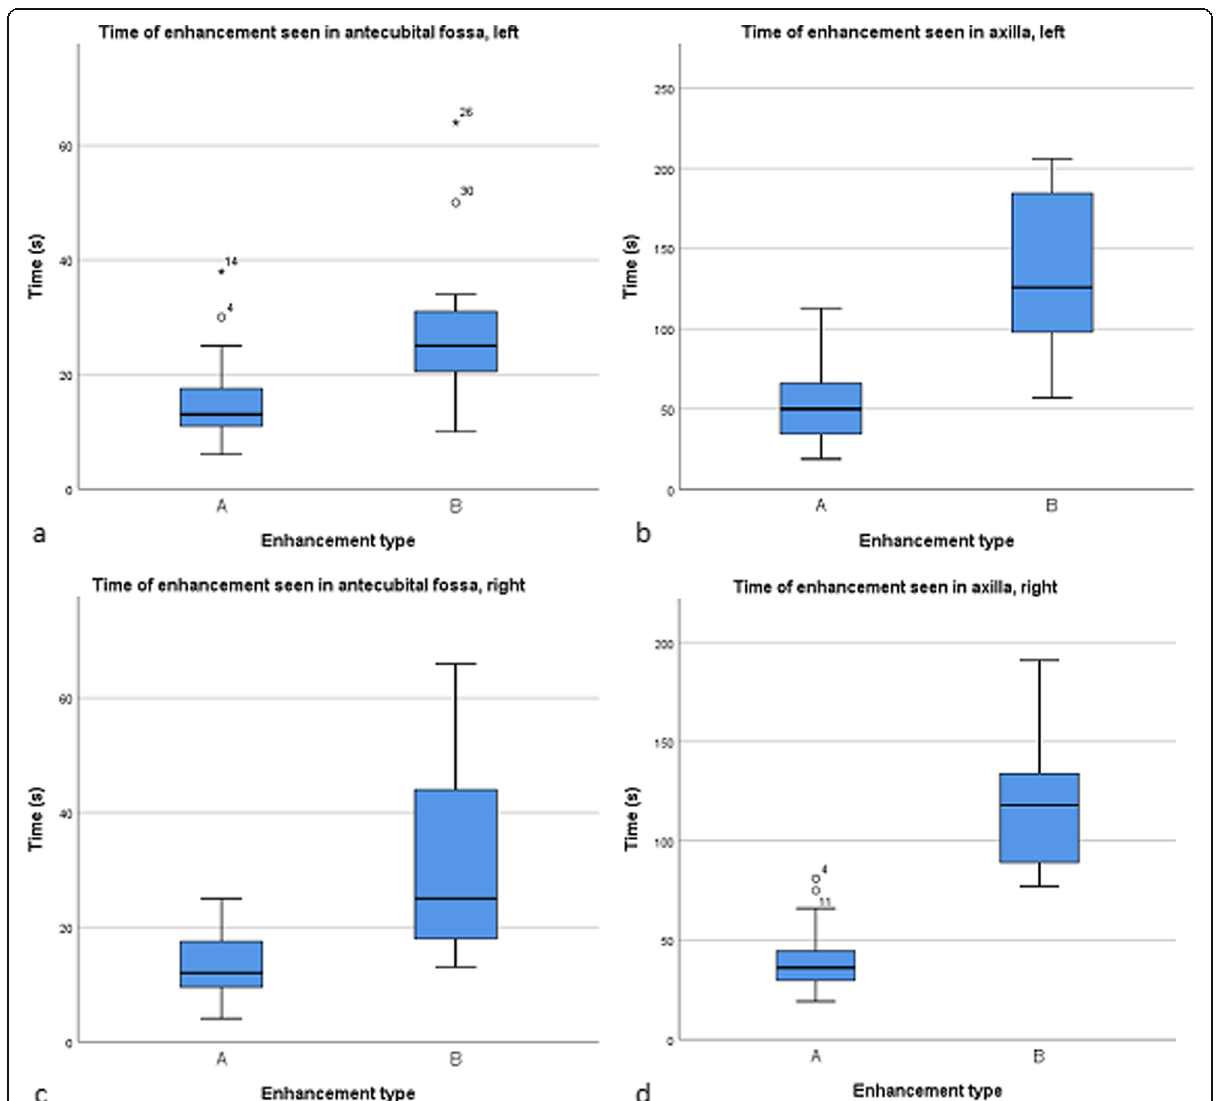
Fig. 5 Enhancement times in antecubital fossa ( a , c ) and axilla ( b , d ) displayed variance according to the two US enhancement categories (type A = strong, type B = moderate) in the right and left arms